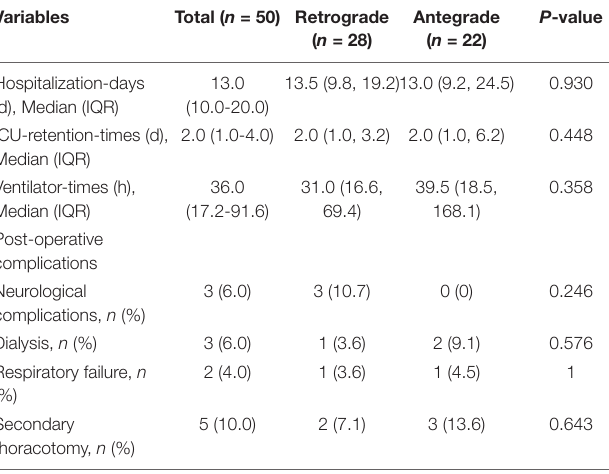
TABLE 4 | Post-operative outcomes.